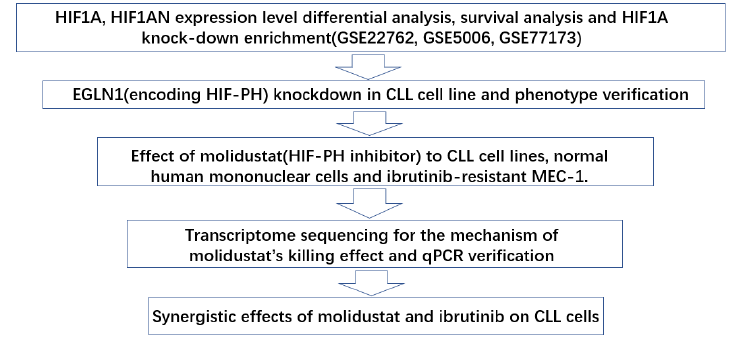
Figure 2. Flowchart of this work.